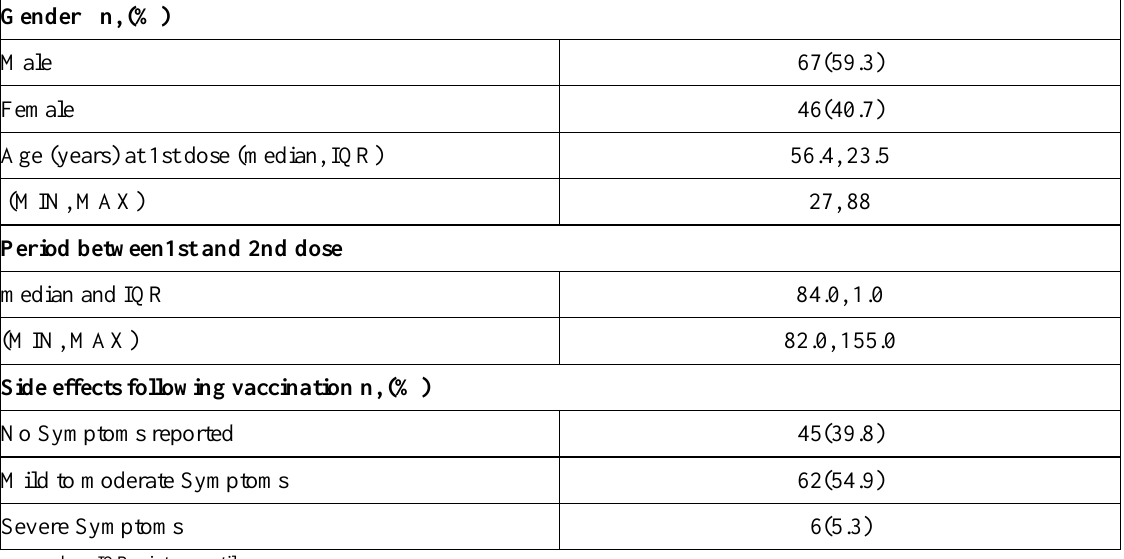
Table 1. Demographic and clinical characteristics of the vaccinated group.